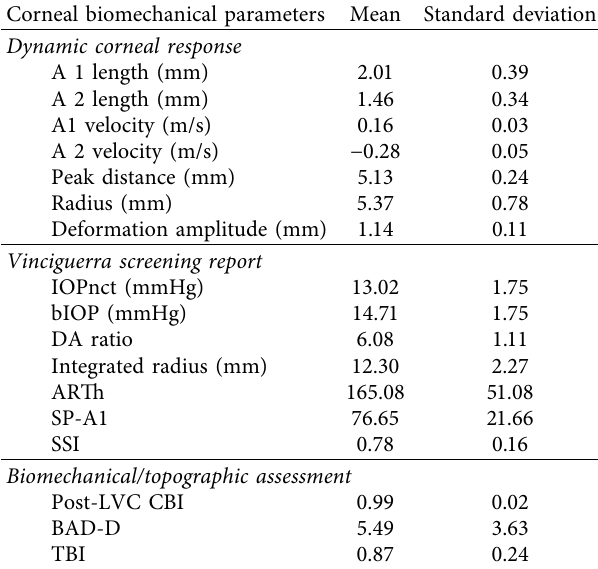
Table 3: Corvis ST combined with Pentacam for corneal biome- chanical analysis in post-LASIK ectasia.